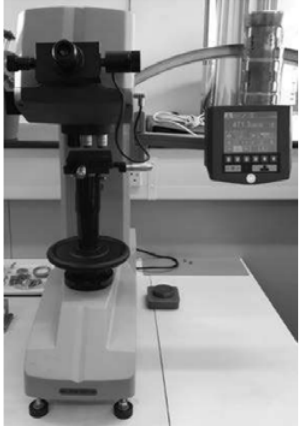
Figure 5. Wilson hardness testing machine utilized in the current research.